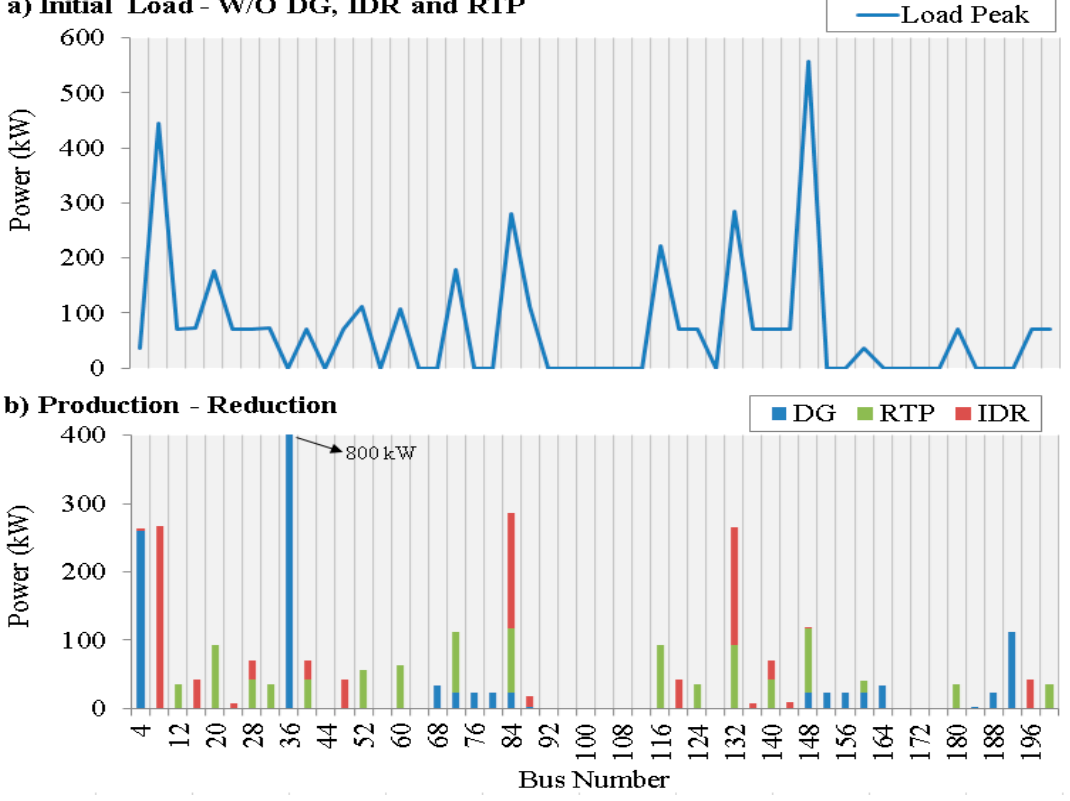
Figure 3. Production versus Consumption: ( a ) initial load—W/O Distributed Generation (DG), Incentive Demand Response (IDR) and RTP; ( b ) production-reduction. Table 2. Selected Scenario Results.